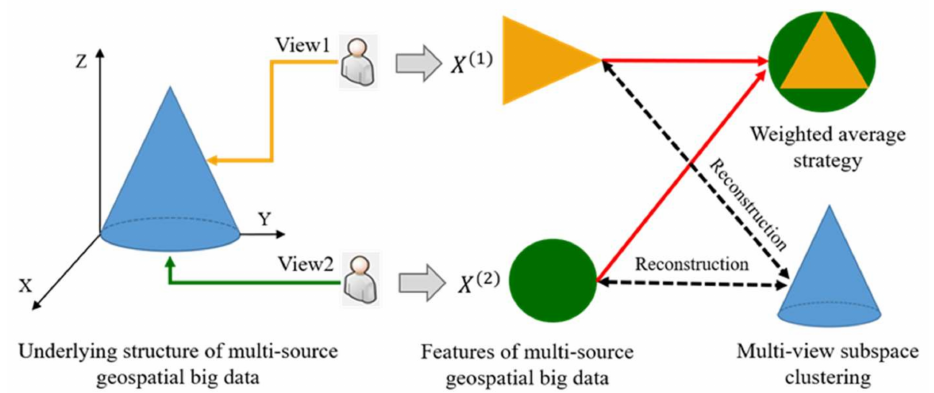
Figure 1. Illustration of the weighted average strategy and multi-view subspace clustering for fusing multi-source geospatial big data ( types of geospatial big